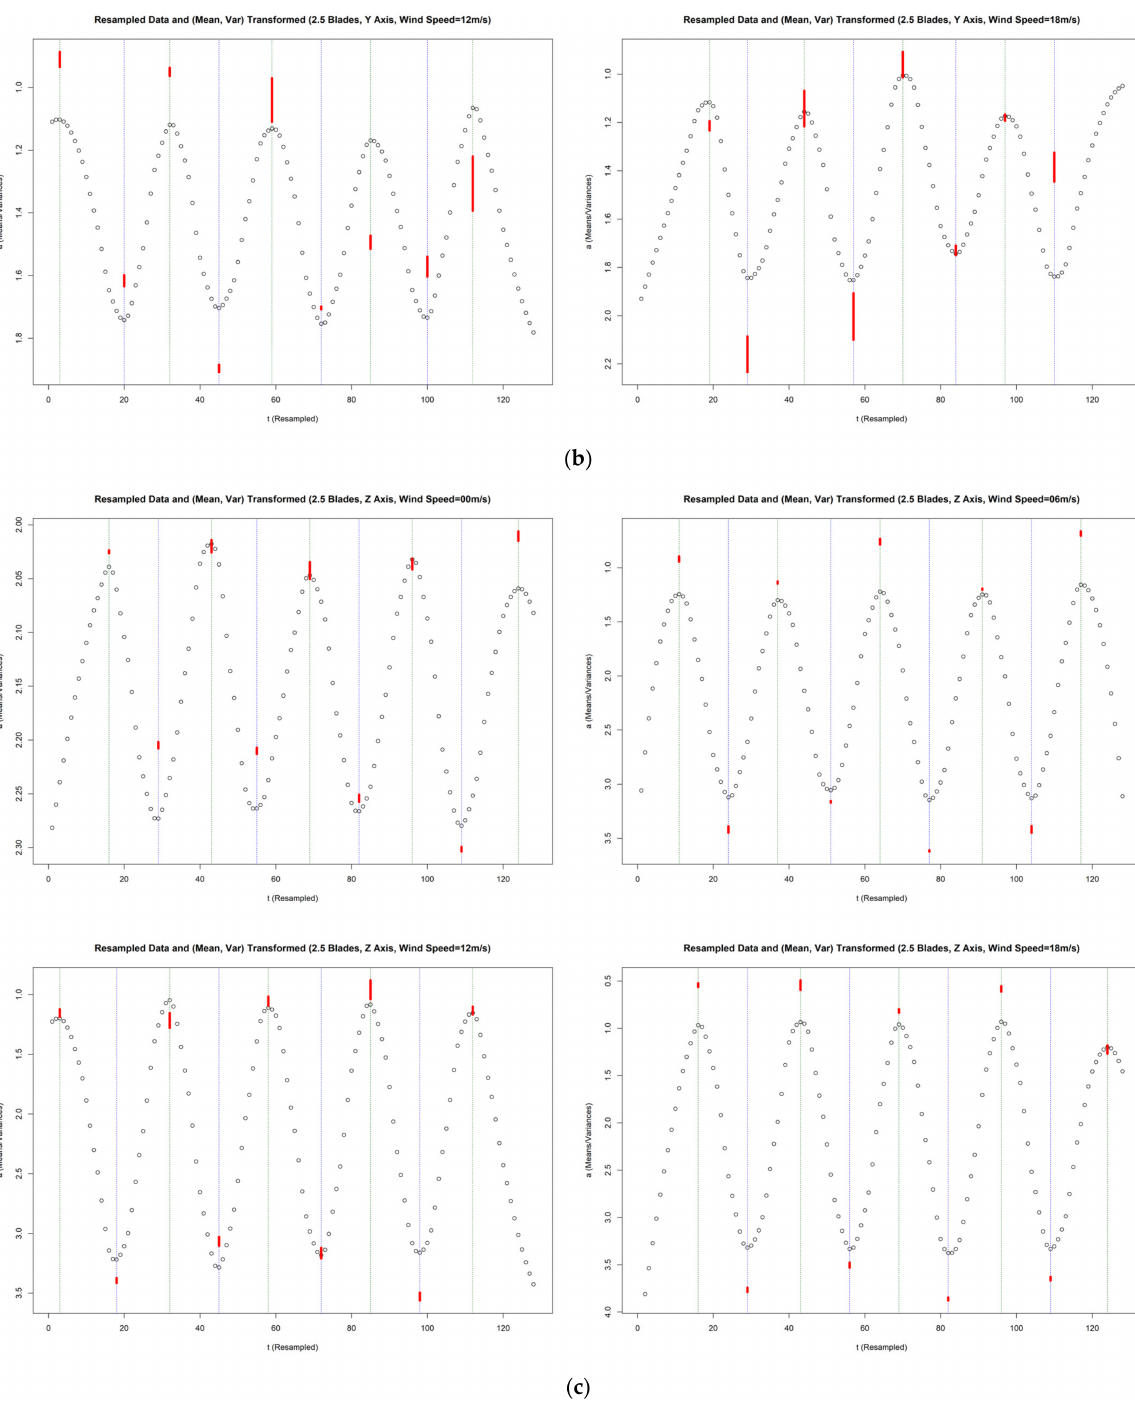
Figure A8. Means and peak/valley variances of resampled data for the 2.5-blade turbine. ( a ) Based on datasets recorded along the X axis with different wind-speeds imposed. ( b ) Based on datasets recorded along the Y axis with different wind-speeds imposed. ( c ) Based on datasets recorded along the Z axis with different wind-speeds